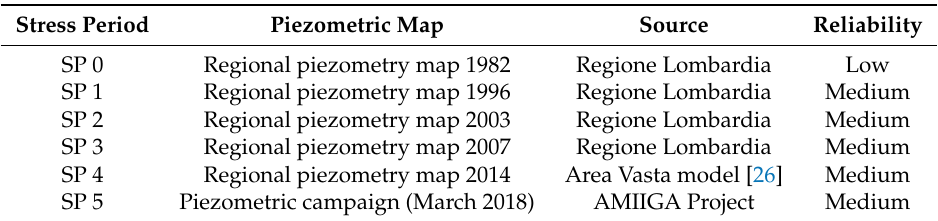
Table 2. Constant Head